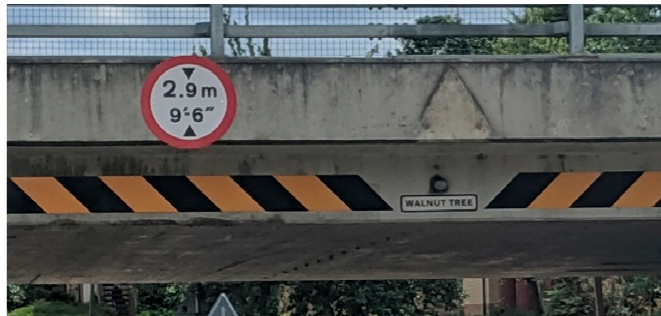
Figure 5. A Redway, a bridge and an intersection in the Kent’s Hill District of Milton Keynes. Permission granted by Marston.